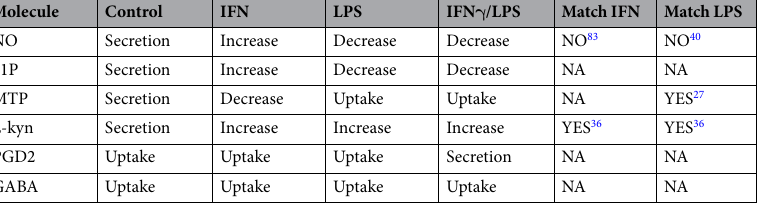
Table 2. Biomarker mean exchange directions and relative levels compared between control, LPS, IFN γ and combined LPS/IFN γ iHUVEC2552 based models. (NA = no applicable data). Nitric oxide (NO), 5